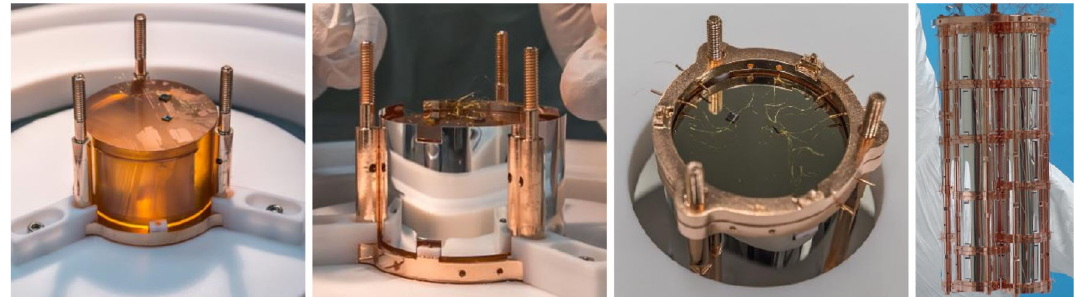
Fig. 1 Pictures of the CUPID-0 detector. From left to right: a ZnSe crystal, the same crystal surrounded by the reflecting foil, the Ge light detector mounted on top, the CUPID-0 array of 26 scintillating